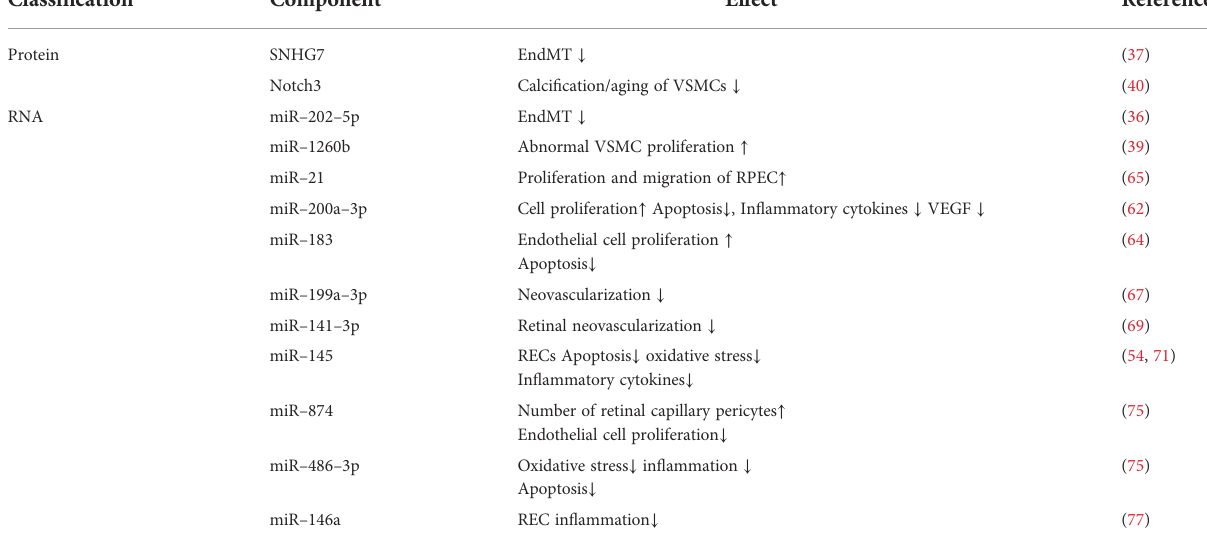
TABLE 1 List of exocrine derived proteins and RNA involved in diabetic retinopathy. Classi fi cation Component Effect Reference